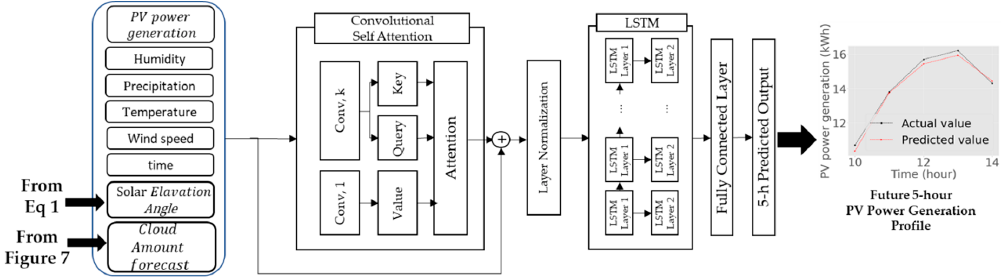
Figure 8. Photovoltaic (PV) power generation forecasting model using convolutional self-attention LSTM.